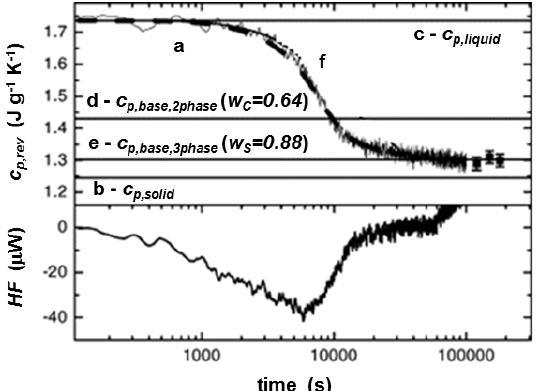
Figure 3. Time evolution of reversing specific heat capacity ( c p,rev ) during quasi-isothermal crystallization of PHB at 23 °C ( p = 100 s and A T = 0.4 K), curve a. Curves b and c correspond to the solid and liquid specific heat capacities ( c p,solid and c p,liquid ), respectively, as taken from [22]. Curve d was estimated from a two-phase model, Equation (3), and curve e from a three-phase model, Equation (5). The squares represent measurements at modulation periods ranging from 240 to 1200 s. Curve f (thick dashed line) is the expected c p,rev curve from model calculations, see text. At the bottom, HF is the average heat flow rate (Reprinted (adapted) with permission from [31]. Copyright (2003) Elsevier). The final crystalline weight fraction ( w C ), equal to 0.64, was obtained from integration of the